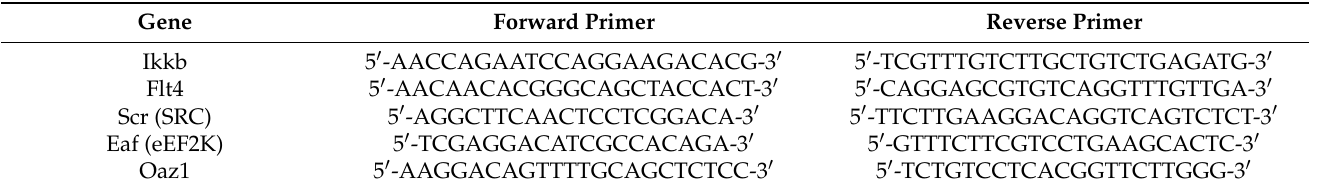
Table 4. The primer sequences used for RT-qPCR target the following genes.